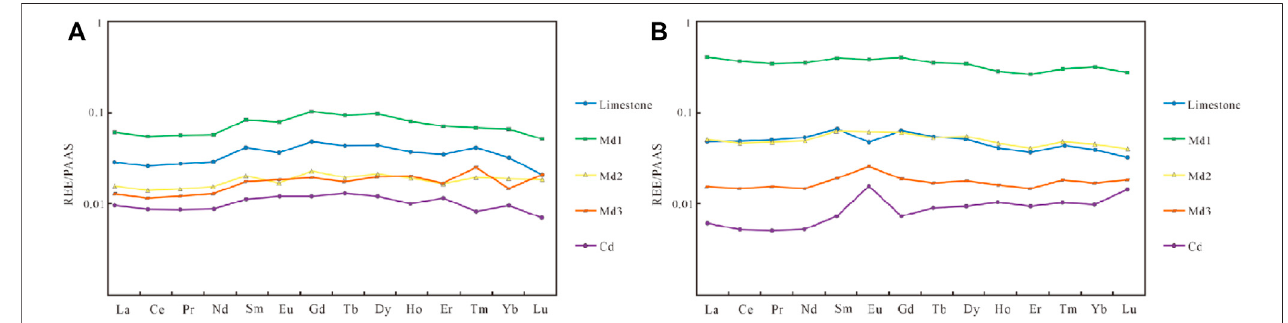
FIGURE 8 | Post-Archean Australian Shale (PAAS; Pourmand et al., 2012) normalized mean rare Earth element (REE) patterns of limestones and four types of dolomites. (A) Northwestern (NW) study area; (B) southwestern (SW) study area.